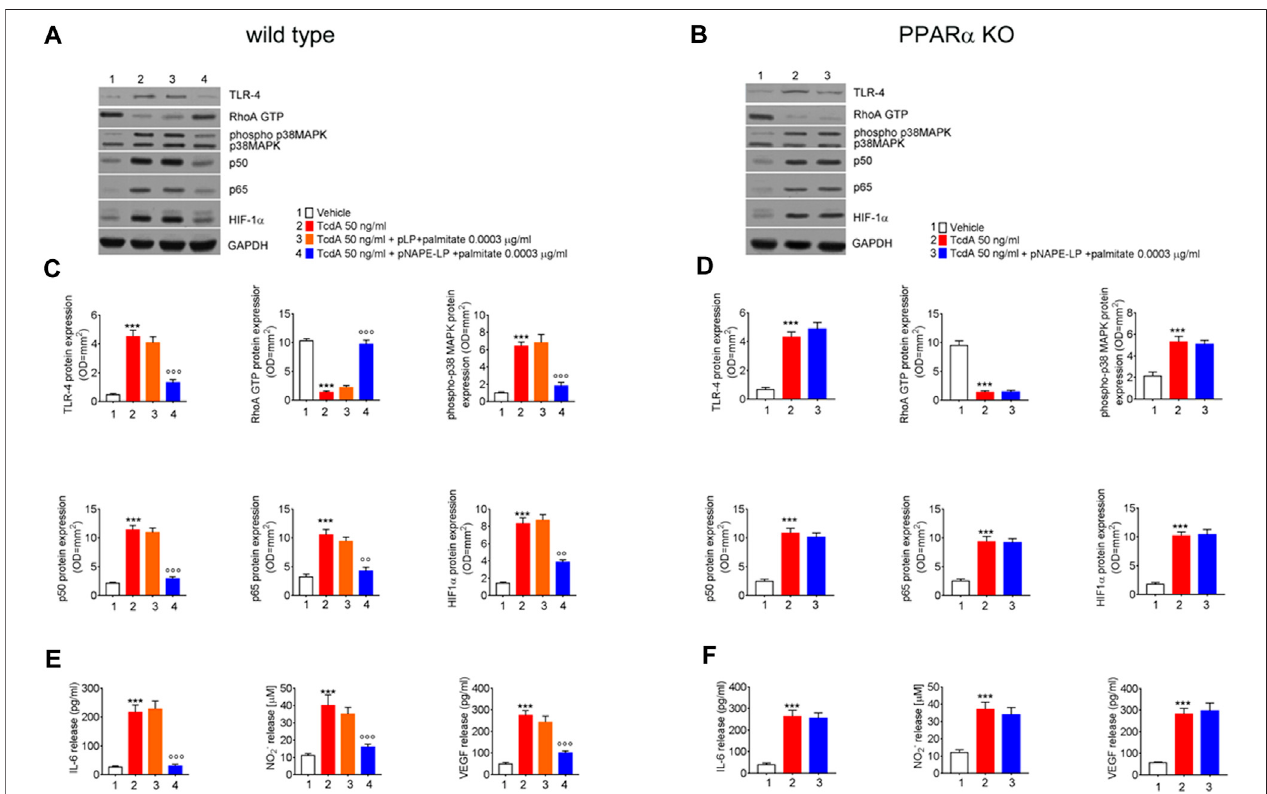
FIGURE 4 | Prophylactic administration of pNAPE-LP and ultralow palmitate administration on pro-in fl ammatory signaling molecules expression and release in mice colon. Immunoreactive bands showing TLR-4, RhoA GTP, phosphorylated/unphosphorylated - p38 MAPK, NF- κ B-related p50 and p65, and HIF-1 α protein expression in both wild type (A) and PPAR α KO (B) mice following TcdA challenge and their relative PPAR α -dependent decrease following pNAPE-LP/palmitate co- administration. Relative densitometric analysis (C , D) of each protein (arbitrary units normalized on the expression of the housekeeping protein GAPDH). Results wereexpressedasmean ± SEMof n (cid:2) 6experimentsperformedintriplicate.*** p < 0.001vs.vehicle;and ooo p < 0.001and oo p < 0.01vs.TcdA.The fi gurealsoshowsthe effect of pNAPE-LP on TcdA challenged wild type (E) and PPAR α KO mice (F) in terms of release of IL-6, nitric oxide (NO), and VEGF in the plasma. Results were expressed as mean ± SEM of n (cid:2) 6 experiments performed in triplicate. *** p < 0.001 vs. vehicle; and ooo p < 0.001 vs.